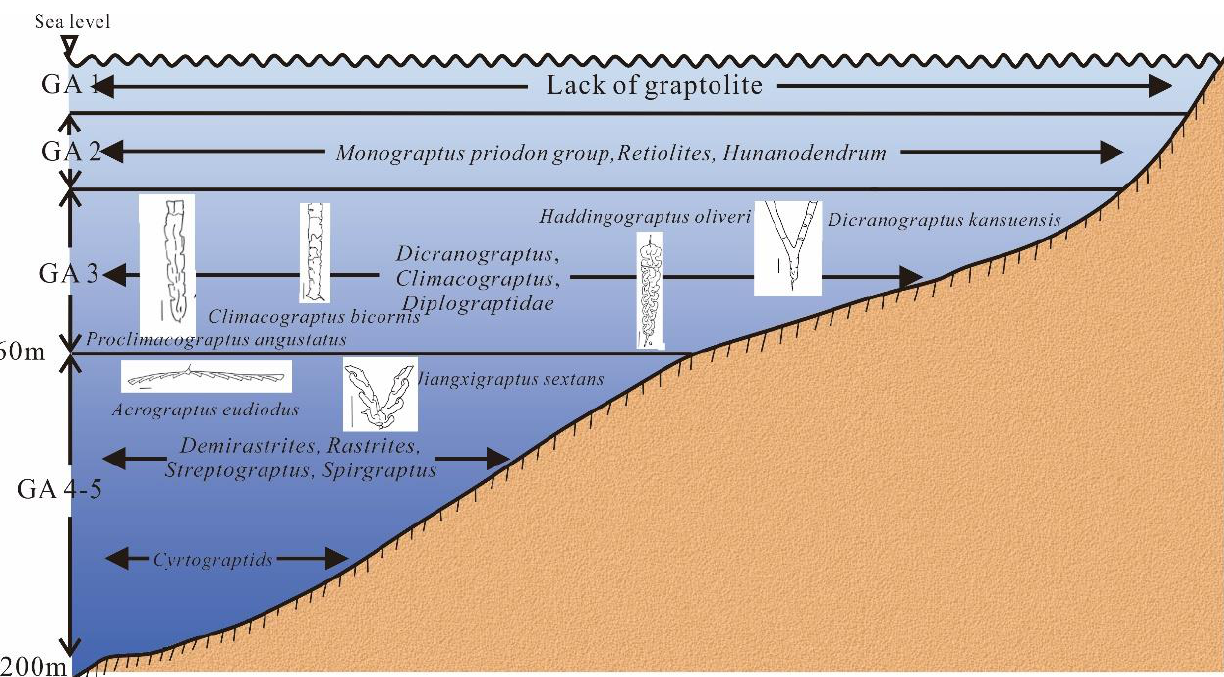
Figure 8. Depth zoning pattern of graptolites (according to [71,72]).